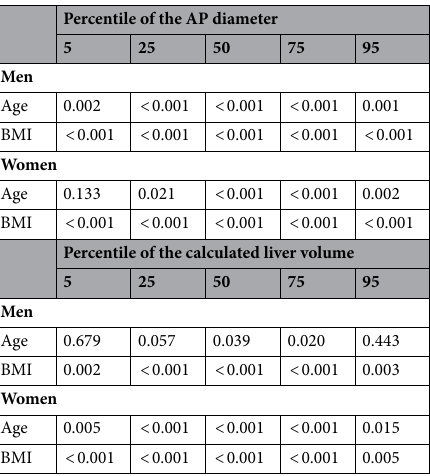
Table 3. Results of quantile regression for gender specific correlation of AP diameter and the calculated liver volume with increased BMI and